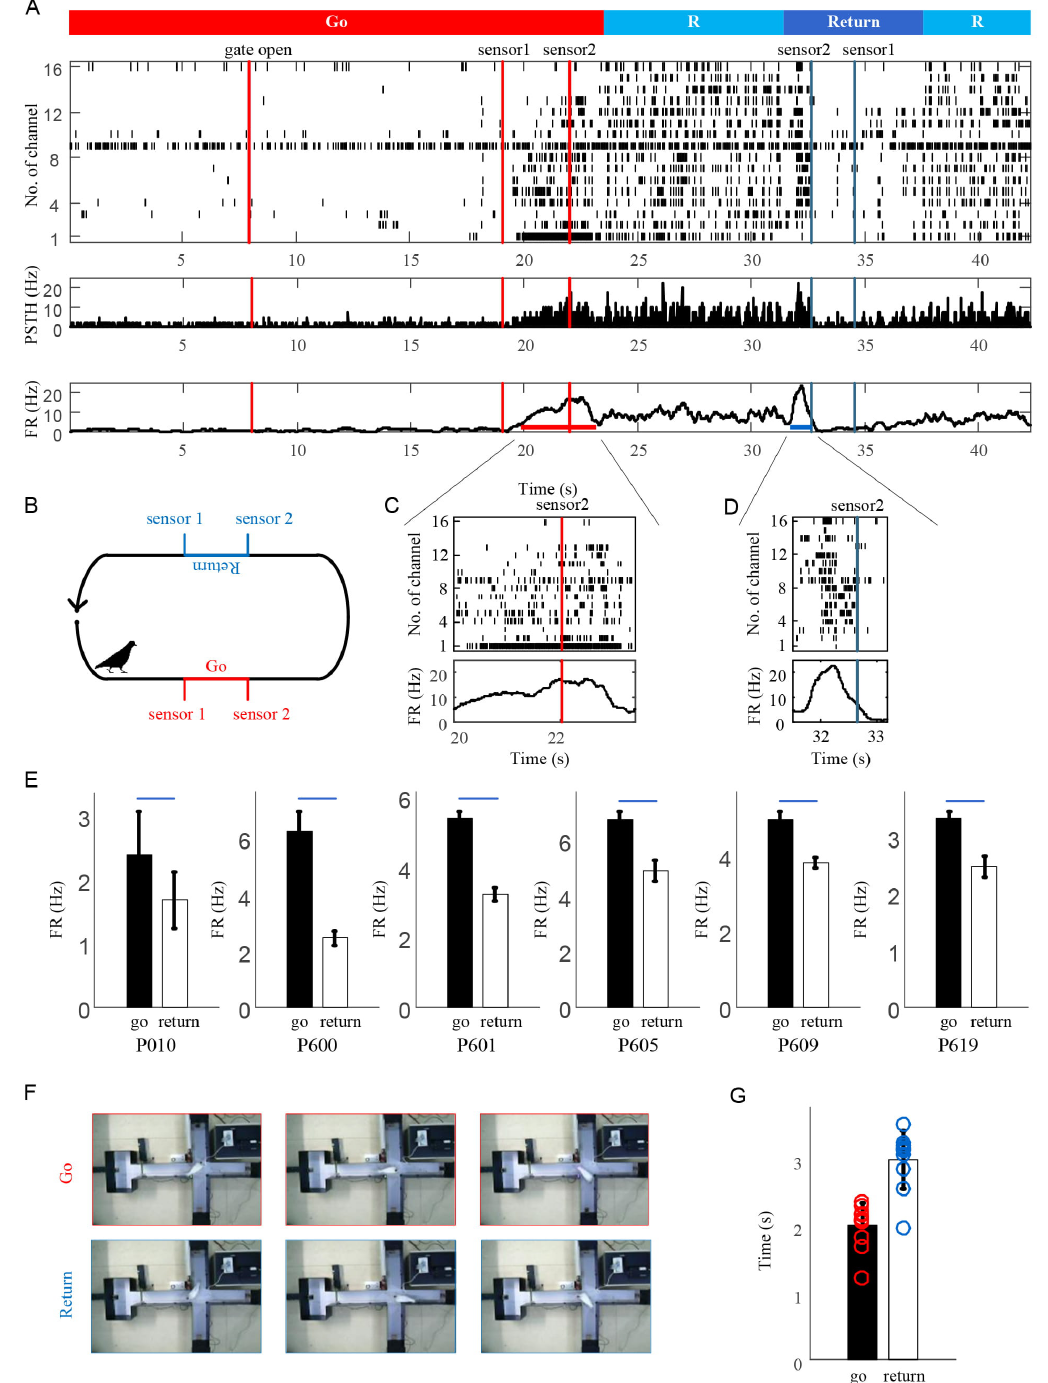
Fig. 3. NCL neural activities in the random-goal task. (A) Example of neural activity in a trial. From top to bottom: illustration of the different event windows, spike trains, peri-event time histogram (PSTH), and firing rate (FR) curve. The event window is marked with a colored rectangle. R: food rewards. A dot raster shows a spike for spike trains. The firing-rate curve is obtained by averaging the dot raster and smoothing it with a 0.1 s boxcar window. Vertical color lines indicate when the pigeon passes the corresponding infrared detector. Horizontal color lines highlight the response of neurons. (B) Diagram of decision-making window, which is marked with the color lines. (C) and (D) Enlarged view of the detail, marked in the horizontal line in (A). (E) Comparison of firing rate between going and returning at the intersection is marked in (B). (F) Behavioral photographs of the pigeon at the intersection of the maze. Top: photographs of the turning in going. Bottom: photographs of the turning in returning. (G) Comparison of the duration for the decision-making between going and returning. The circle denotes the mean value of all trials for a pigeon, in which the red circle represents the going, and the blue circle denotes the returning. Error bars indicate standard error of mean